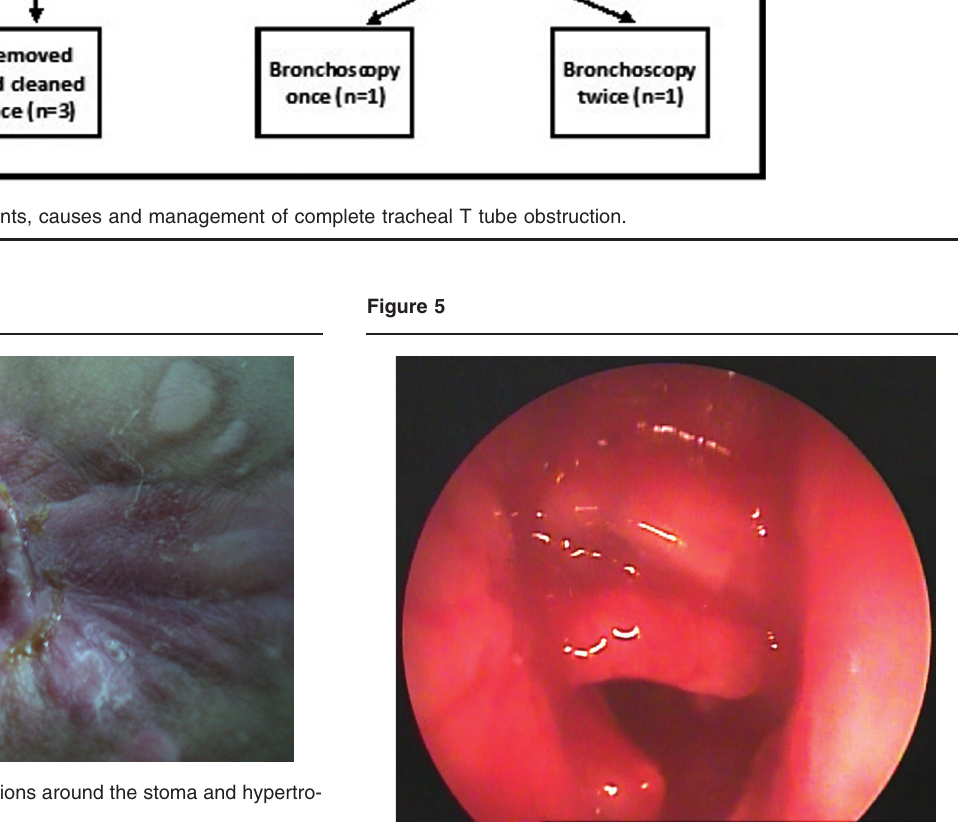
Bronchoscopic view showing granulations at the level of stoma at time of T tube